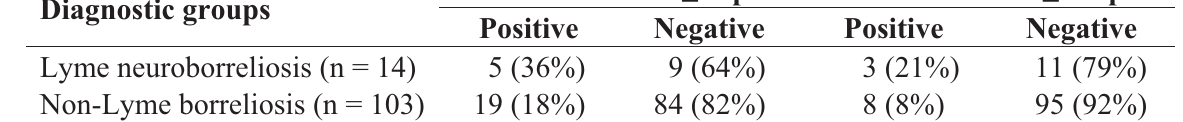
Figure 2. Receiver operating characteristics (ROC)-curve. The true positive rate (sensitivity) was plotted as a function of the false positive rate (1- specificity) for different cut-off points of number of Borrelia induced IFN-(cid:2) secreting